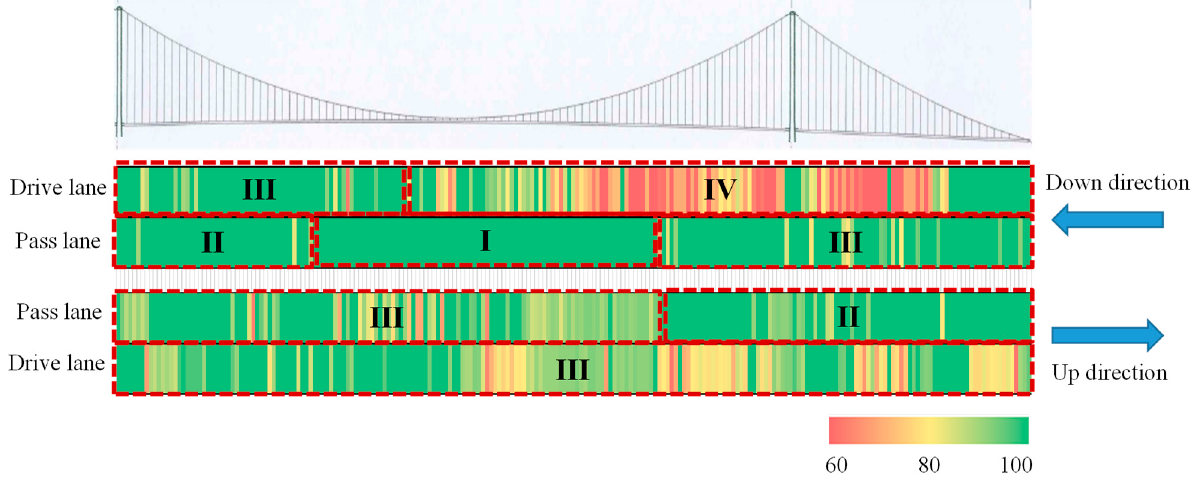
Figure 14. Performance partition of XHMB pavement based on PPI value.